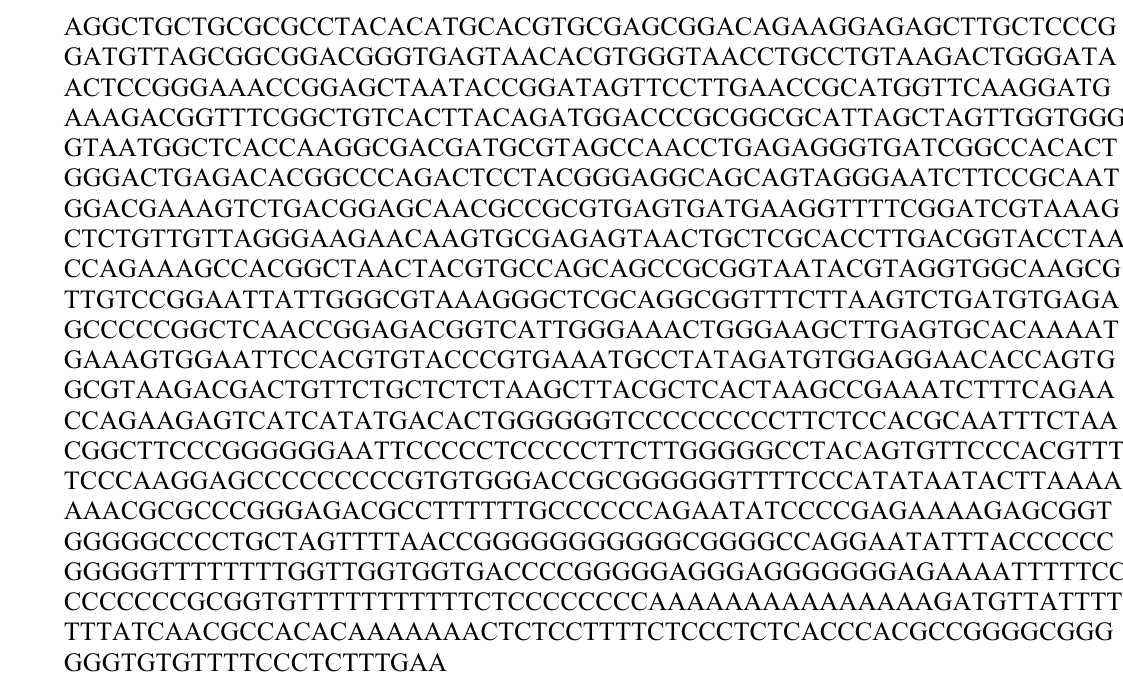
Fig. 3 Large subunit partial sequence of 16S ribosomal RNA of Bacillus